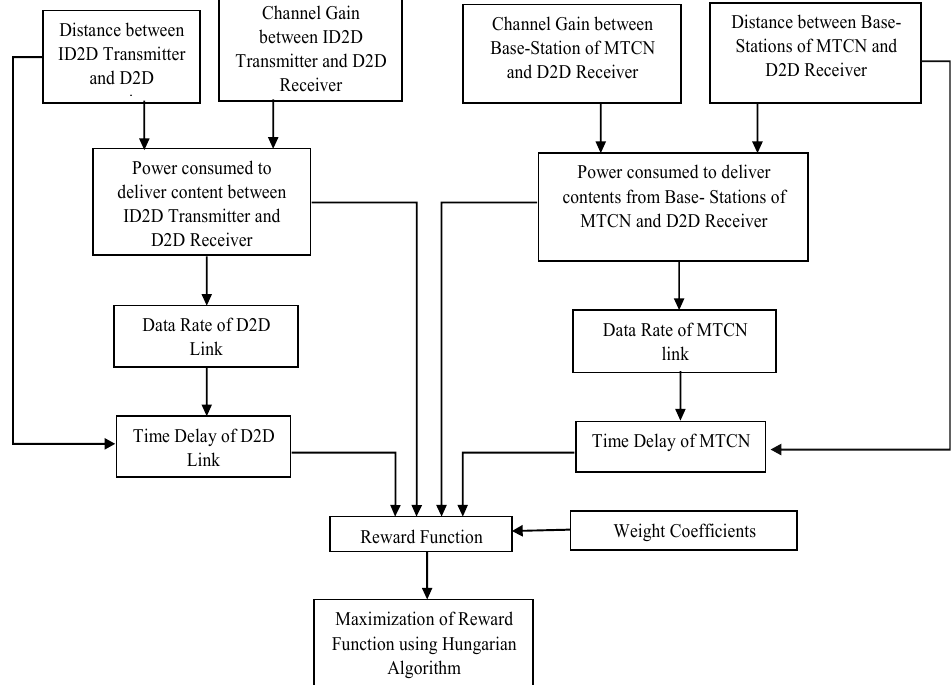
Figure 4. Content delivery strategy based on maximization of reward function.